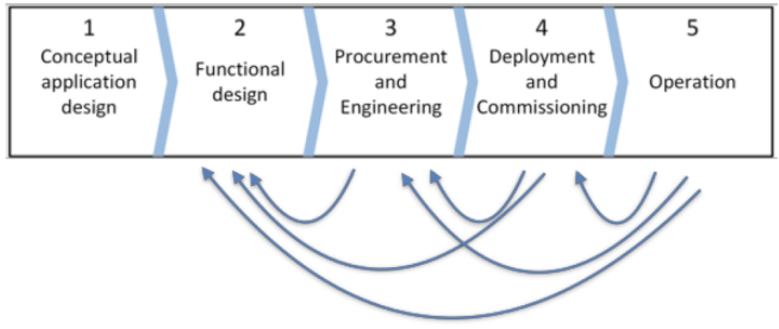
Figure 2. Main engineering process phases of ISO/IEC 81346